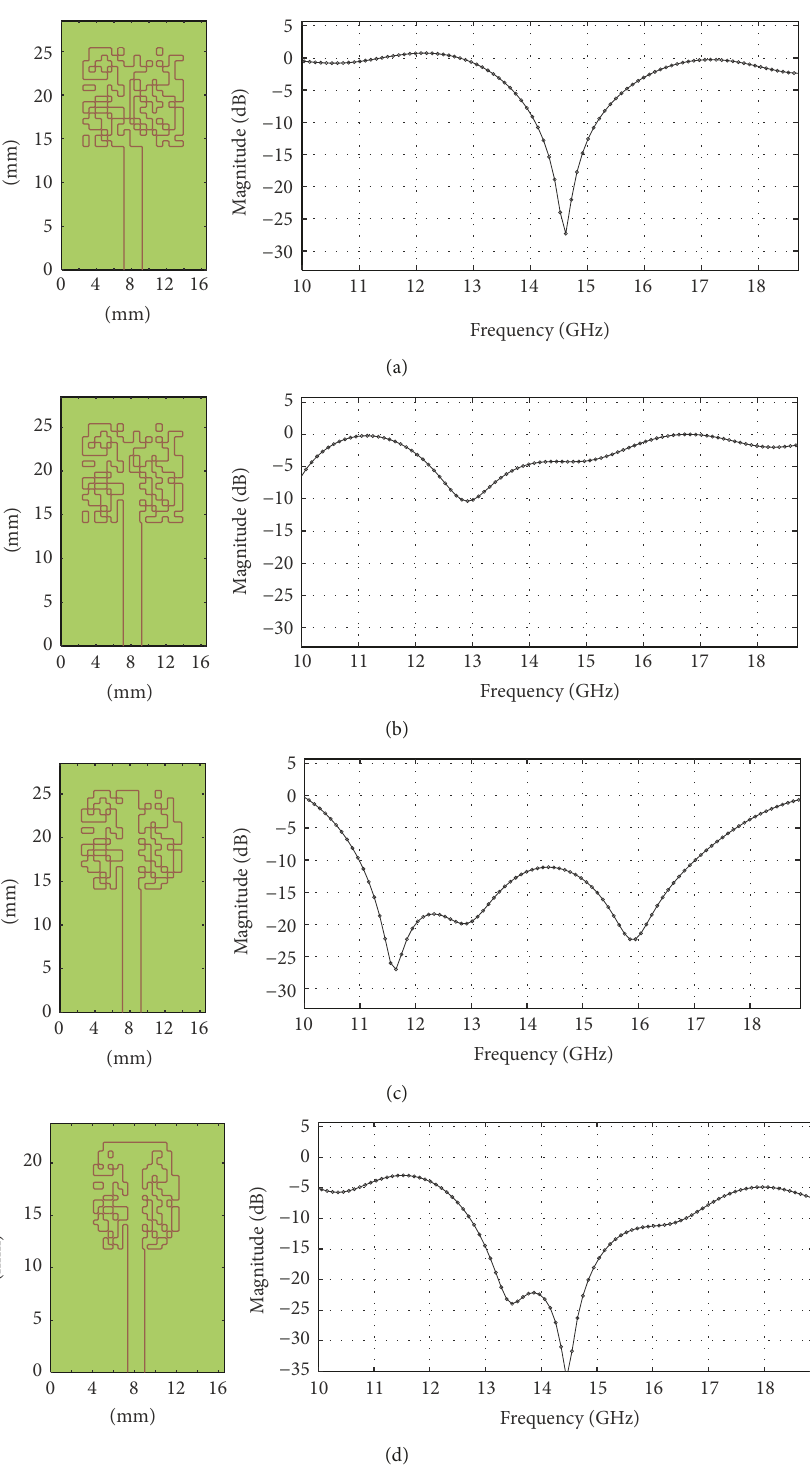
Figure 10: Some snapshots from the evolutionary optimization